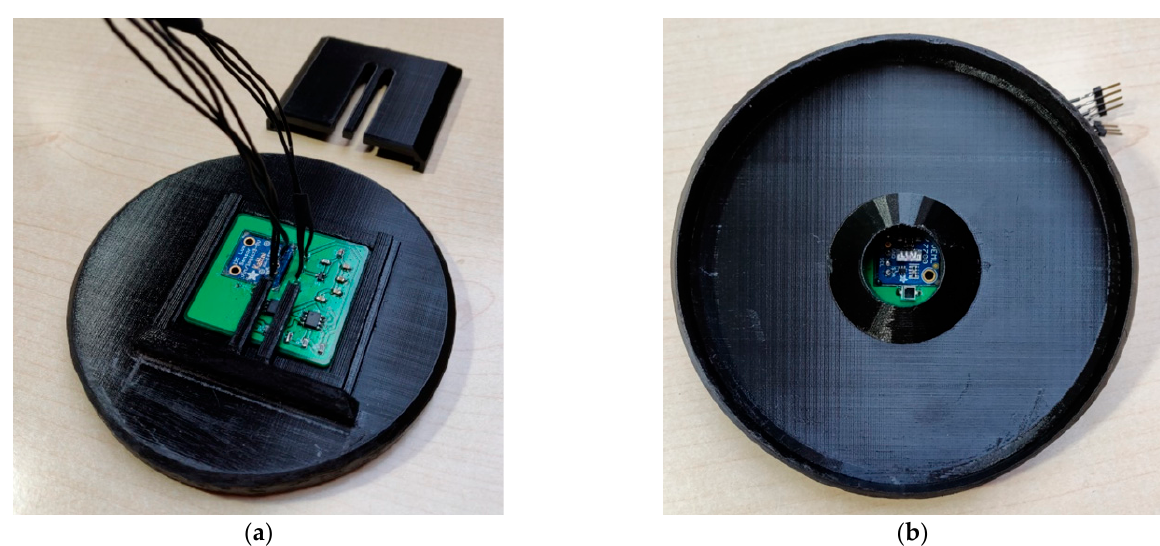
Figure 14. Tunnel lid with positioned sensors: ( a ) The outer side where the PCB with the sensors is placed; ( b ) The inner side, which shows the 20 mm diameter aperture.